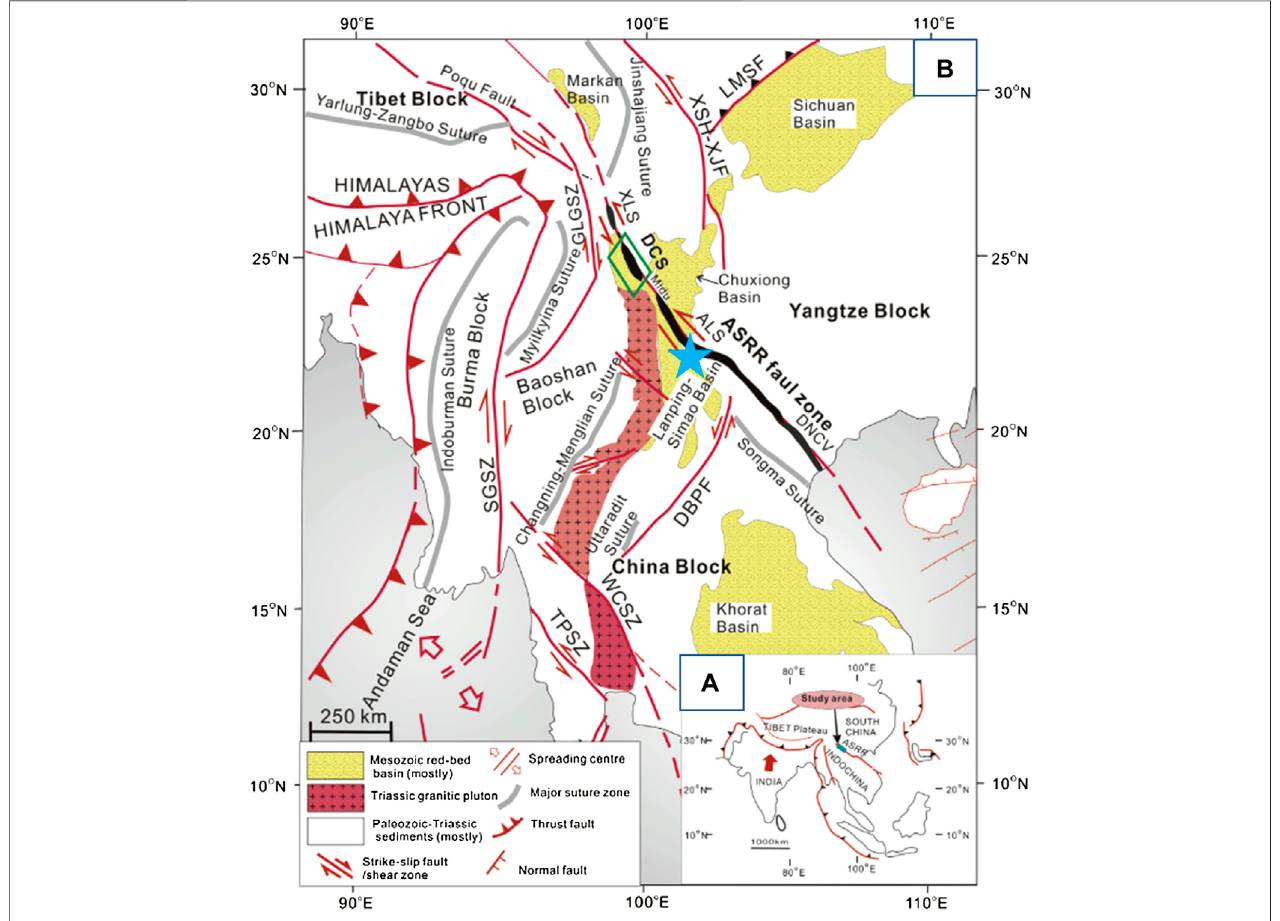
FIGURE 1 | Tectonic sketch map of the Red River fault area (from Cao et al., 2017). (A) Simpli fi ed geological sketch of the extrusion of Indochina. (B) Tectonic sketchmap showing themaintectonic zones andthe locationoftheAilao Shan – RedRiver(ASRR) shearzone atthe easternmargin oftheSE.GLGSZ,Gaoligongshear zone; SGSZ,Sagaing shearzone;TPSZ,ThreePagodashearzone;WCSZ,Wang Chaoshearzone; LMSF,LongmenShanfault;XSH-XJF, Xianshuihe – Xiaojiangfaults; DBPF, Dien Bien Phu fault; ASRRSZ, AilaoShan – Red River shear zone; XLS, Xuelong Shan; DCS, Diancang Shan; ALS, Ailao Shan; DNCV, Day NuiCon Voi; Blue Star, samples